Question: What visual encoding does this figure use to show its data?
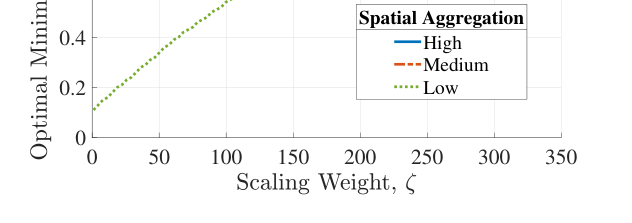
Answer: line